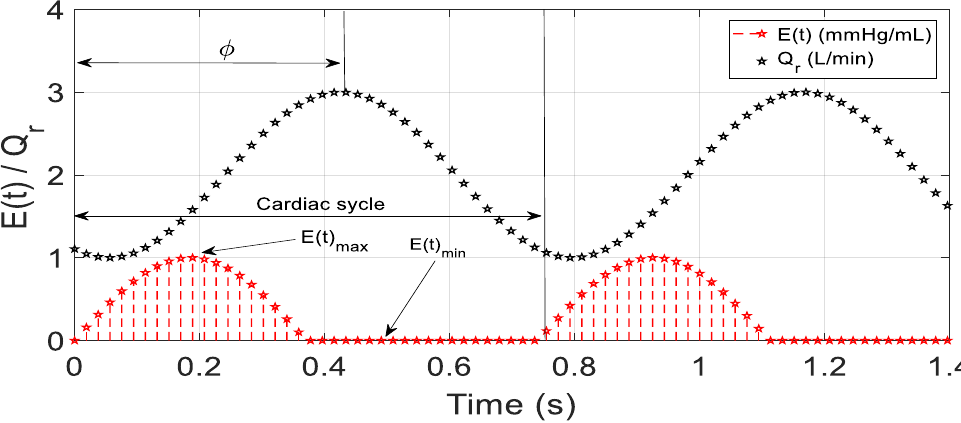
Figure 4. Phase shift for sinusoidal desired reference flow ( 𝑄 𝑟 ) in comparison with elastance function ( 𝐸(𝑡 )).